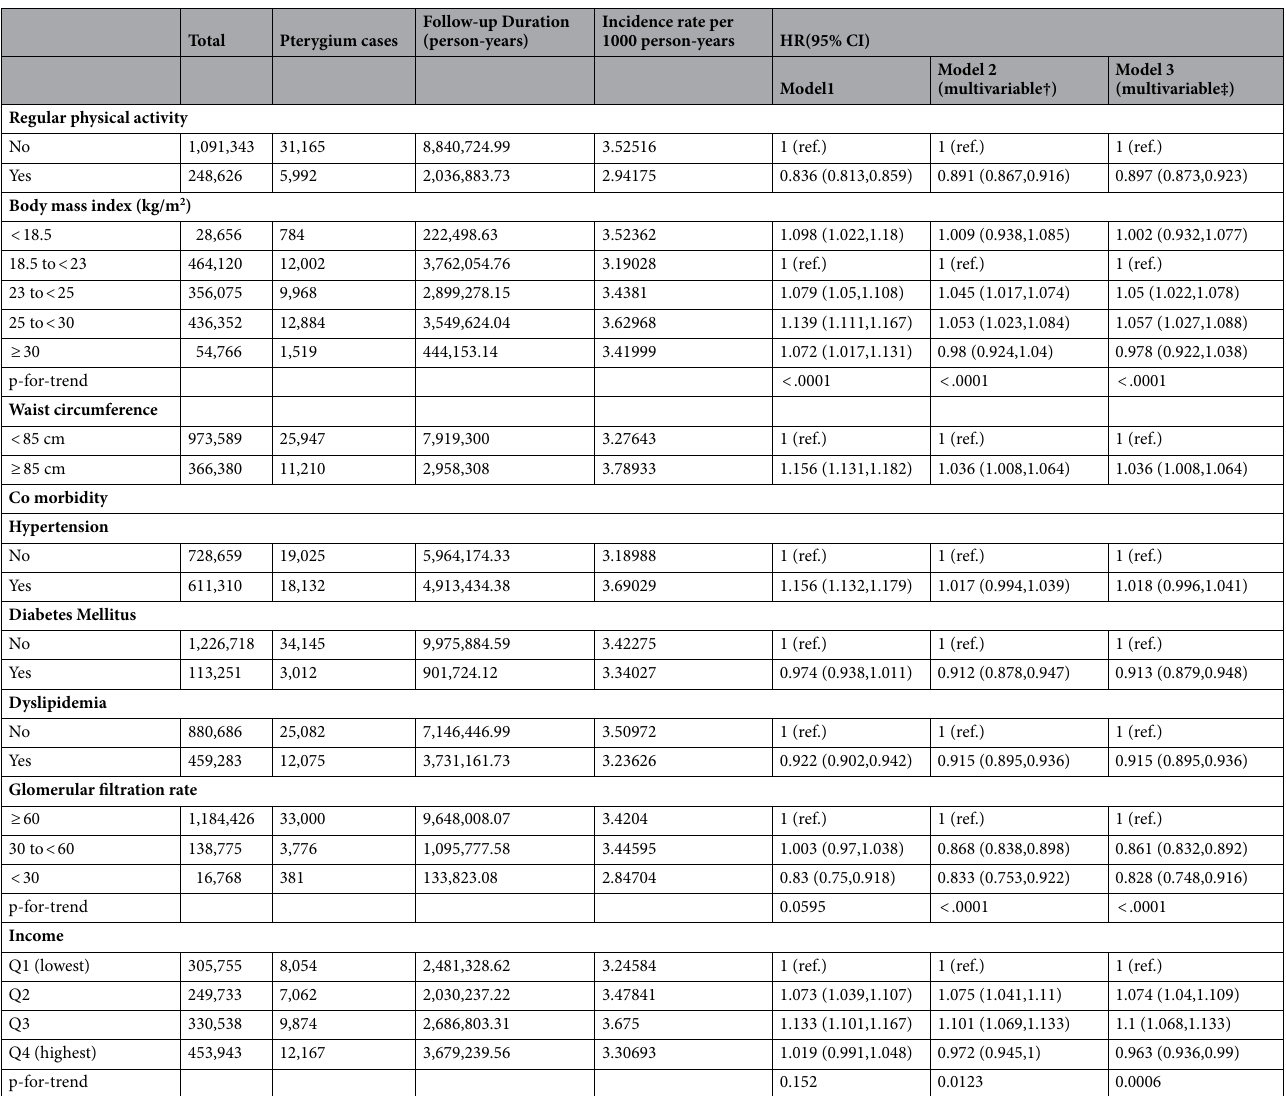
Table 2. Hazard ratios (HR) and 95% confidence intervals (CI) for the association between reproductive factors and the risk of pterygium. IR, incidence rate; HR, hazard ratio; CI, confidence interval. † Adjusted for age, age at menarche and menopause, parity, duration of breastfeeding, duration of HRT, duration of oral contraceptive use, alcohol consumption, smoking, regular exercise, income, body mass index, waist circumference, hypertension, diabetes mellitus, dyslipidemia and glomerular filtration rate. ‡ Adjusted for age, reproductive period, parity, duration of breastfeeding, duration of HRT, duration of oral contraceptive use, alcohol consumption, smoking, regular exercise, income, body mass index, waist circumference, hypertension, diabetes mellitus, dyslipidemia and glomerular filtration